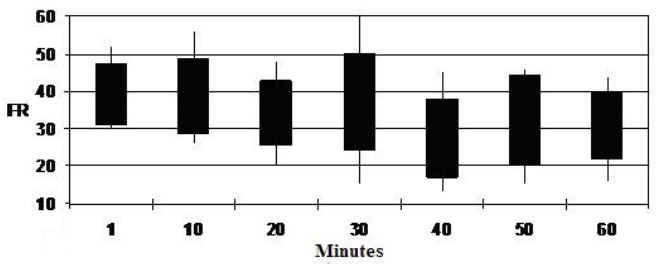
FIGURE 2 - Respiratory Frequency during transoperatory